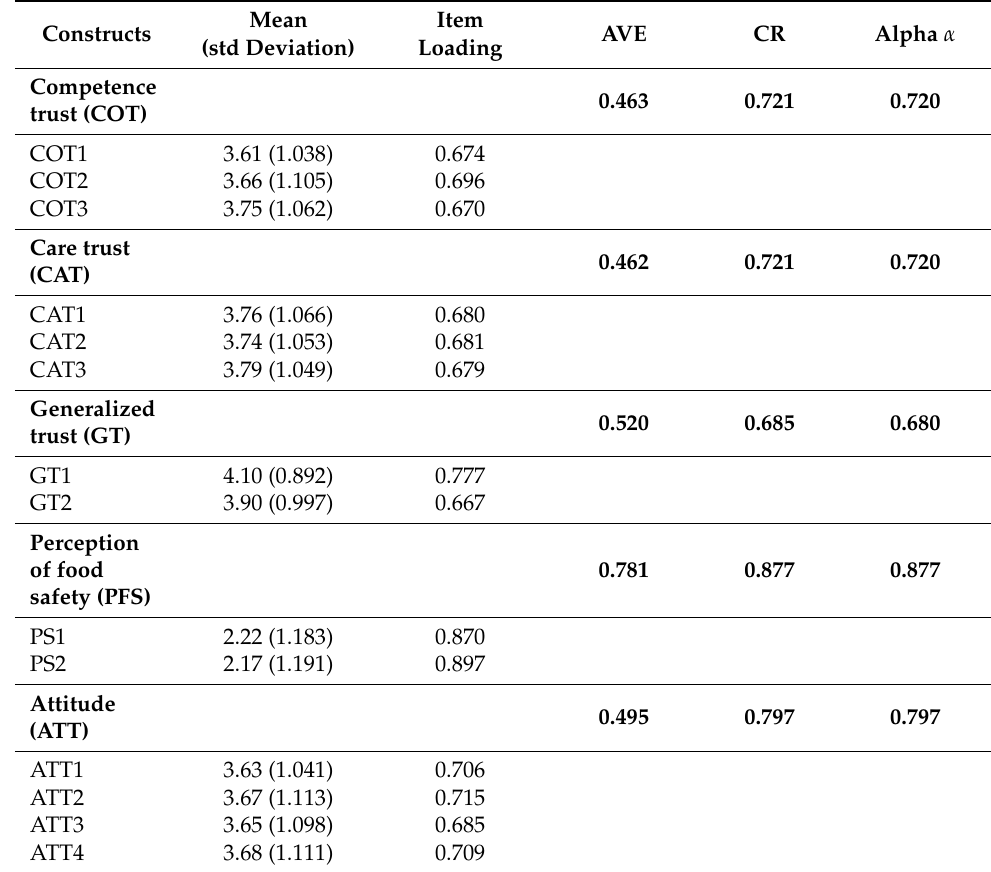
Table 3. Cronbach Alpha, Composite Reliability,